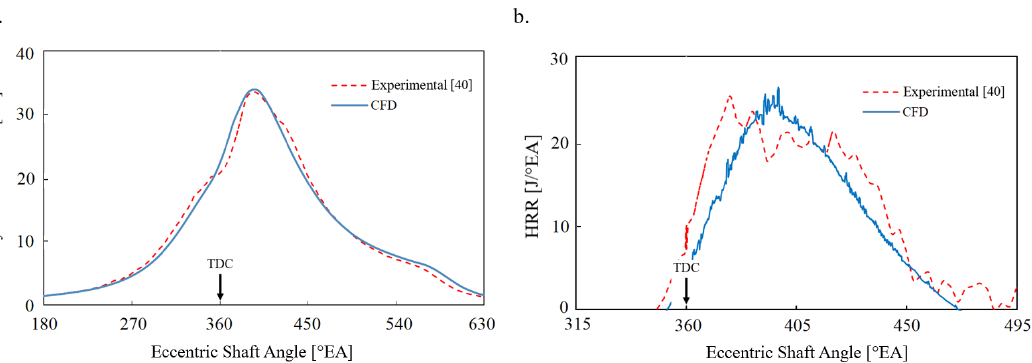
Figure 8. Mesh independence study of; ( a ) in-cylinder pressure, ( b ) HRR results.